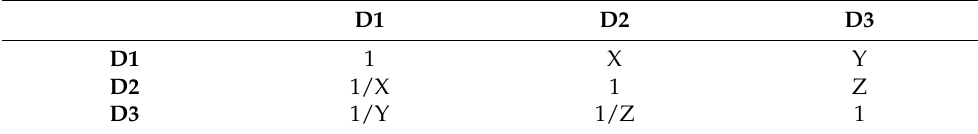
Table 3. Example of pairwise